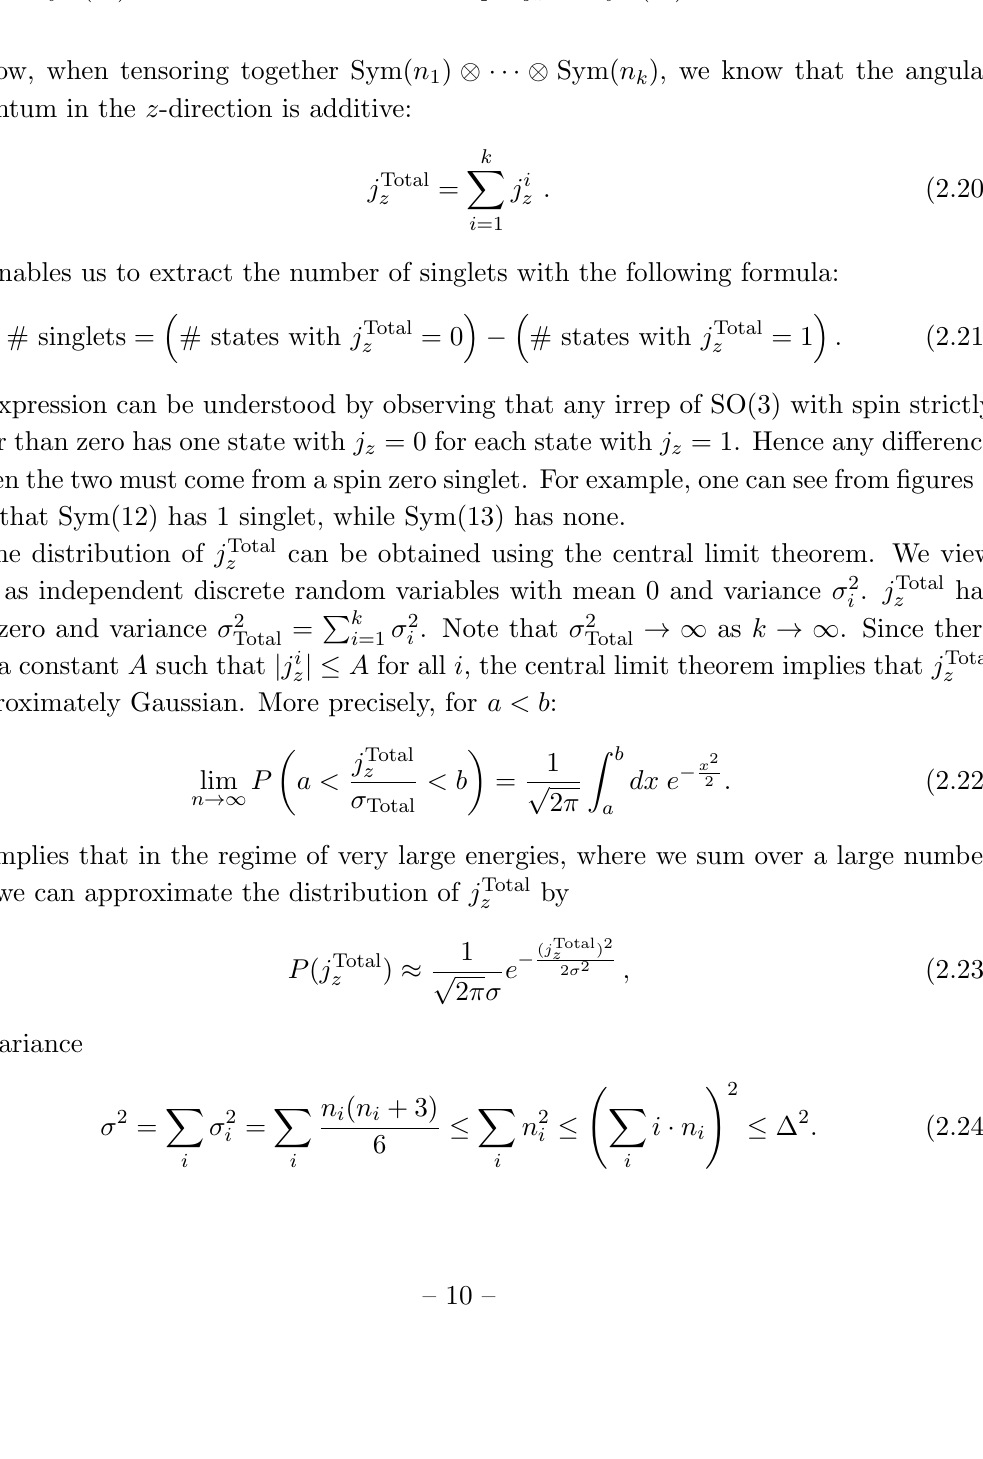
Figure 2 . Distribution of the number of states per j z for